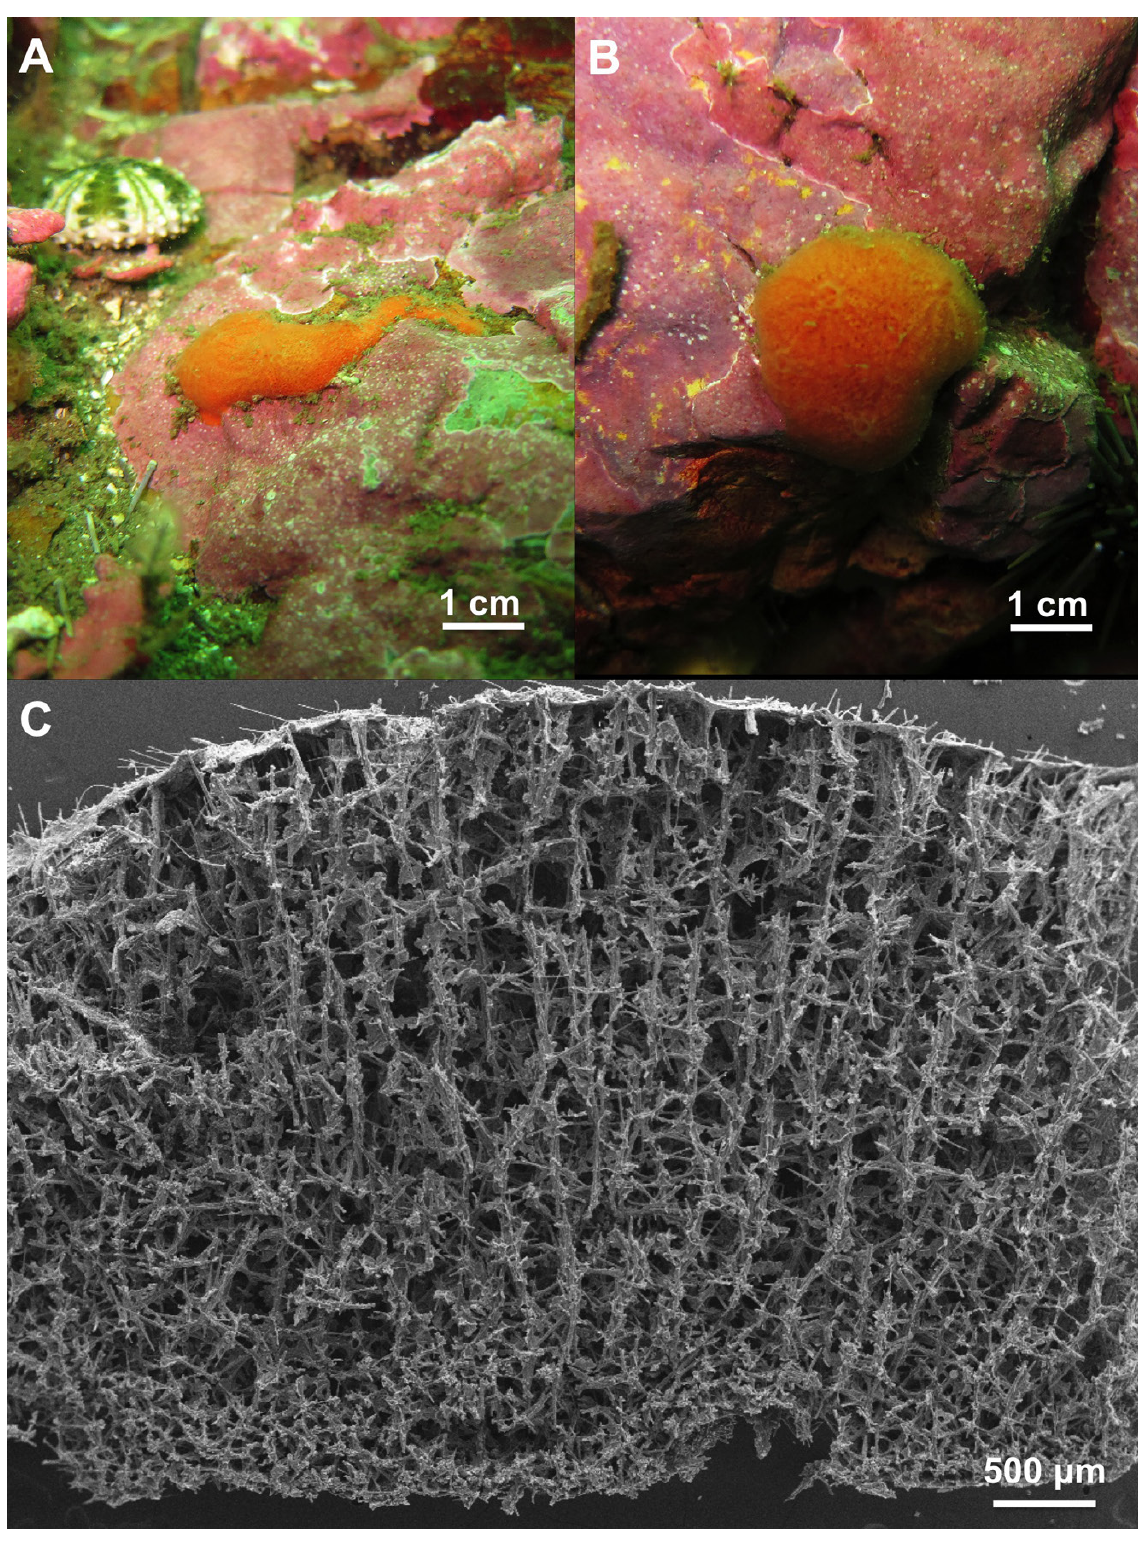
Fig. 7. Biemna aurantiaca Bertolino, Costa & Pansini sp. nov., holotype (CILE 20; MSGN 61497). A–B . The holotype in life. C . Plumoreticulate